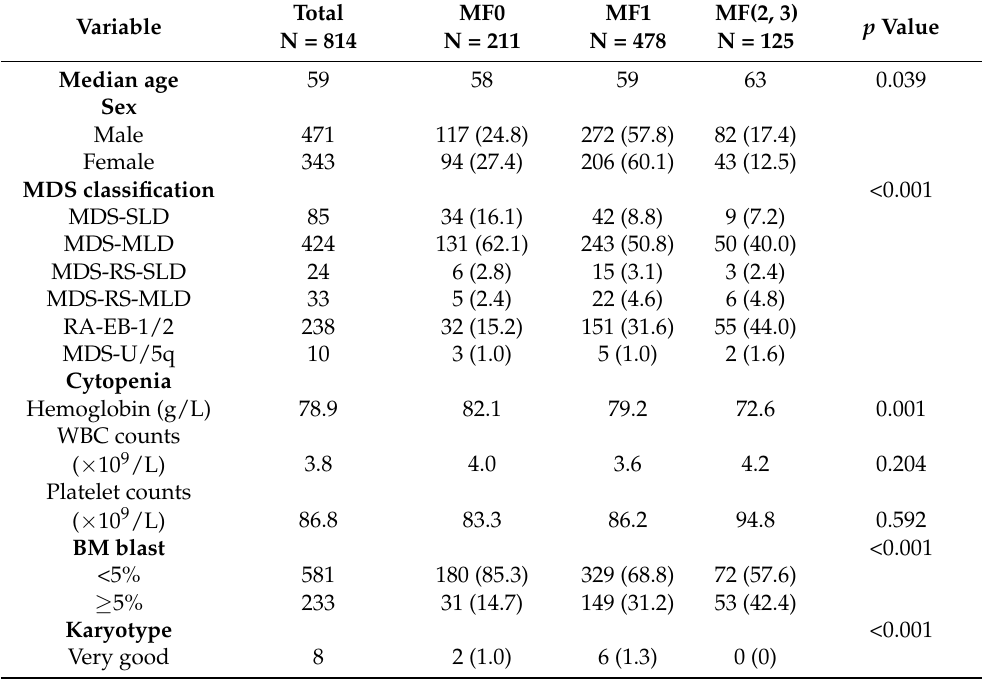
Table 1. Patient